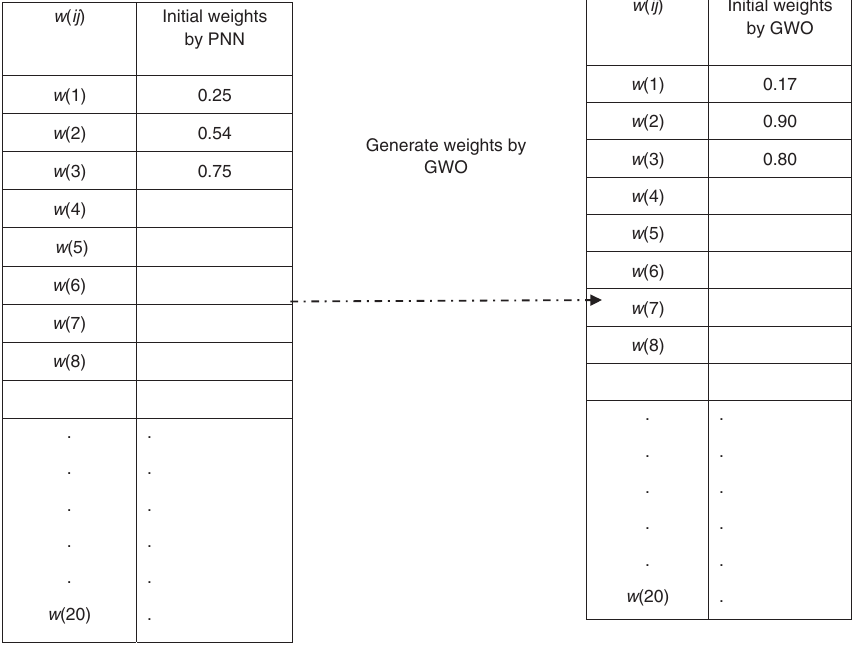
Figure 3: Representation of the Initial Weights. algorithm as described in Figure 2, and were then transmitted to the next layer, i.e. pattern. These are